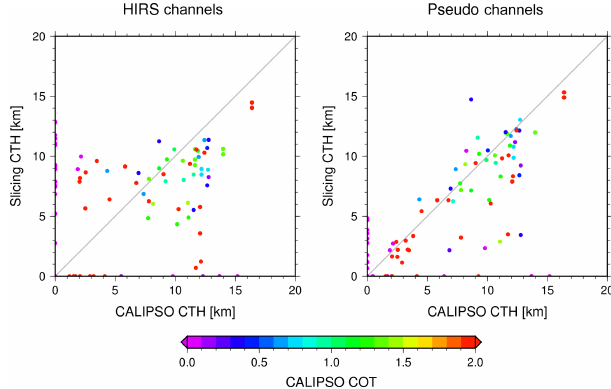
Figure 12. Comparison of the CTH derived from CALIPSO and the slicing method with the pair of original channels corresponding to the HIRS sensor (left), and obtained from the improved slicing method with the optimal pair of pseudo-channels (right). The color is the optical thickness of uppermost clouds from